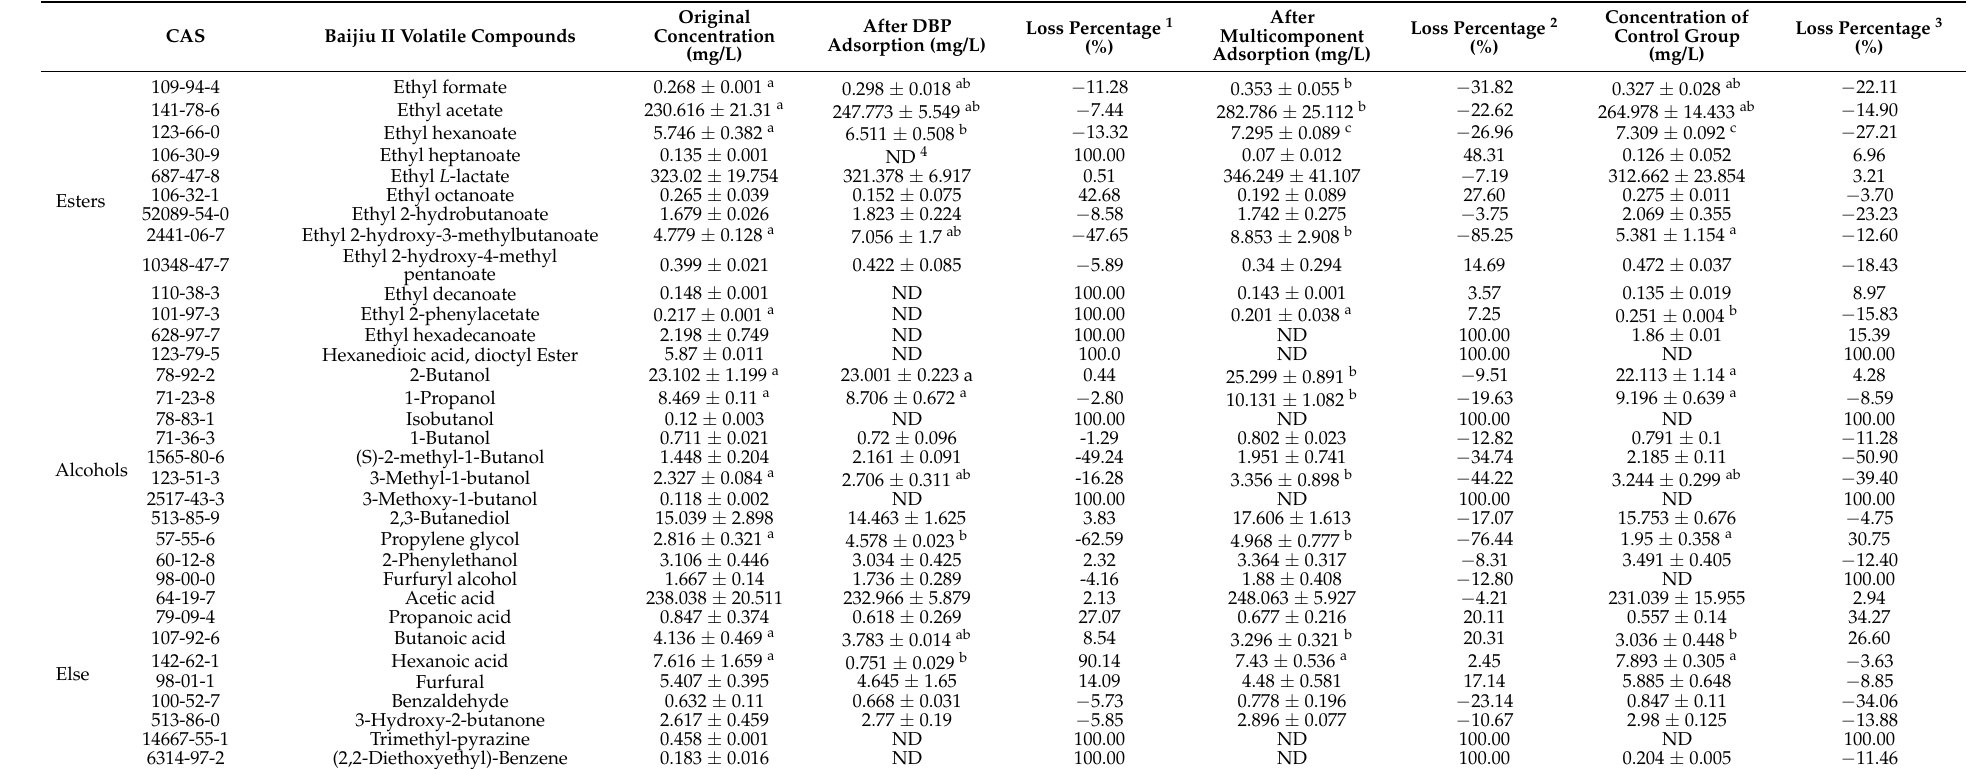
Table 2. Changes in volatile compounds before and after Baijiu II